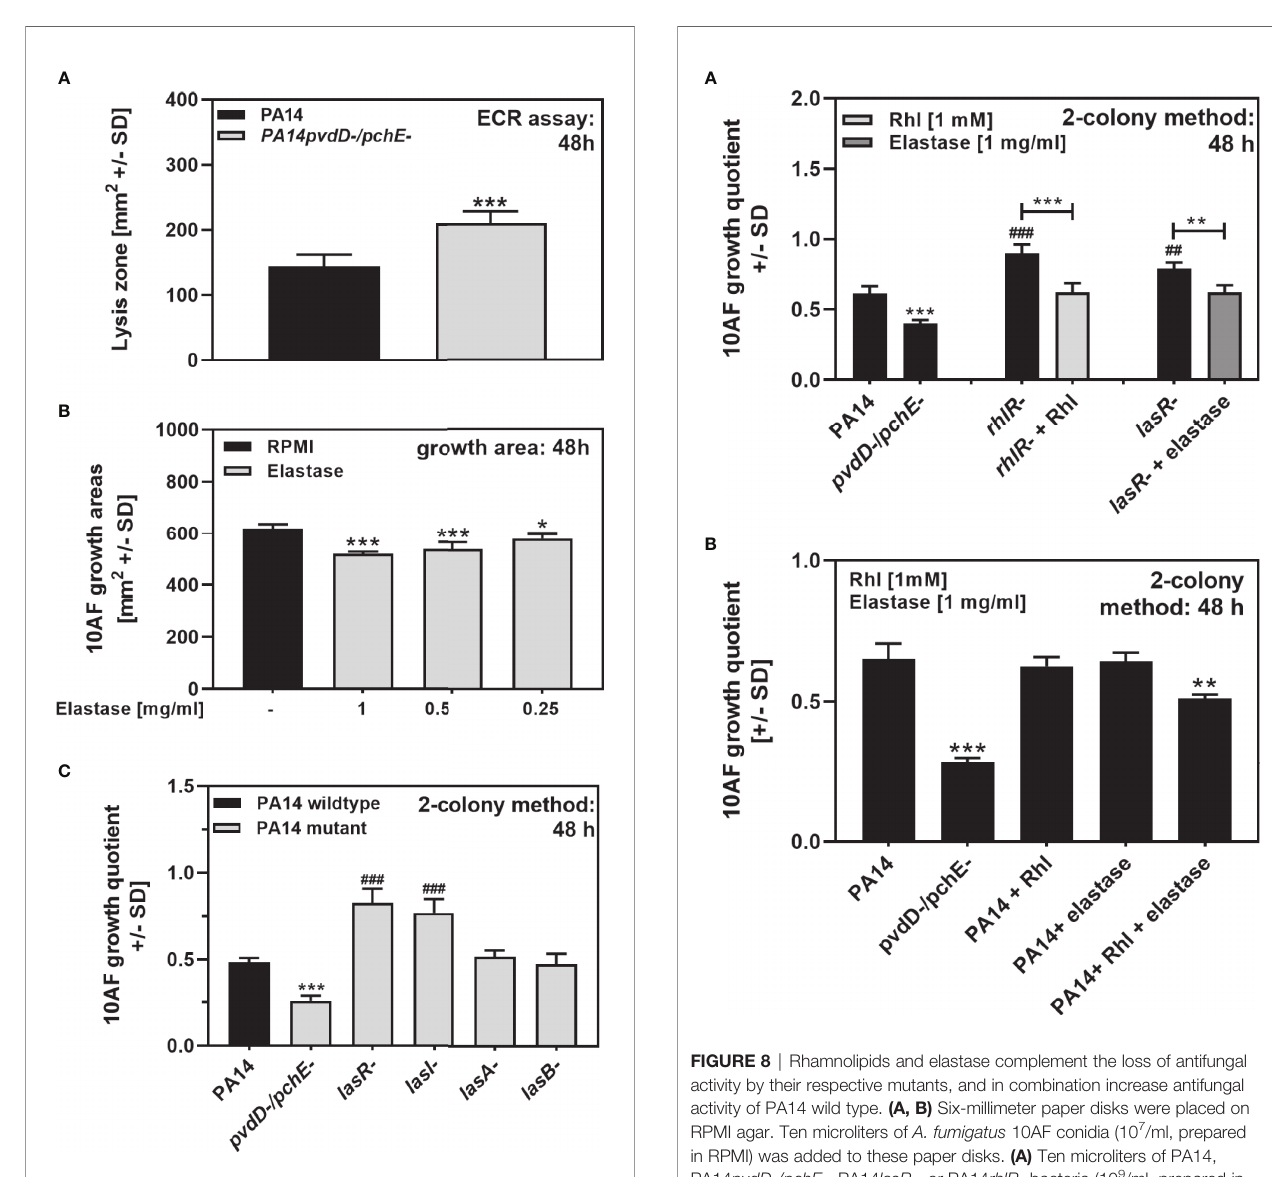
FIGURE 7 | Elastase has antifungal activity on agar. (A) Six-millimeter paper disks were placed on ECR agar. Ten microliters of PA14 wild-type or PA14 pvdD-/pchE- bacteria (10 9 /ml, prepared in RPMI) was placed on the disks. Plates were incubated for 48 h at 37°C, and elastin lysis zones around the disks were determined. (B) Six-millimeter paper disks were placed on RPMI agar. Ten microliters of A. fumigatus 10AF conidia (10 7 /ml, prepared in RPMI) was placed on each disk, and 10 µl of pure elastase was added to the fi lter disks at 1, 0.5, or 0.25 mg/ml. Plates were incubated at 37°C for 48 h, and fungal growth areas were determined. Comparison: PA14 (black bar) vs . all other bars. (C) Six-millimeter paper disks were placed on RPMI agar. Ten miroliters of A. fumigatus 10AF conidia (10 7 /ml, prepared in RPMI) was placed on each disk, and 10 µl of PA14 wild-type, PA14 pvdD-/pchE- , PA14 lasR- , PA14 lasI- , PA14 lasA- , or PA14 lasB- bacteria (10 9 /ml, prepared in RPMI) was placed 15 mm distant from the disks carrying 10AF. Plates were incubated for 48 h at 37°C, and growth quotients were determined. Comparison: PA14 (black bar) vs . all other bars. Statistical analysis in (A – C) , t-test: one or three asterisks or pound signs = p ≤ 0.05 and p ≤ 0.001, respectively. Asterisks represent signi fi cant increases; pound signs represent signi fi cant decreases in elastase production (A) or in antifungal activity (B, C) .